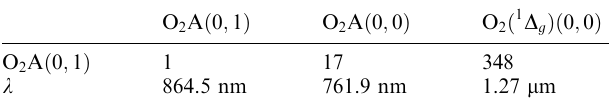
Table 4. Relative band intensities IO (cid:3) of the O (cid:3) band origin 2